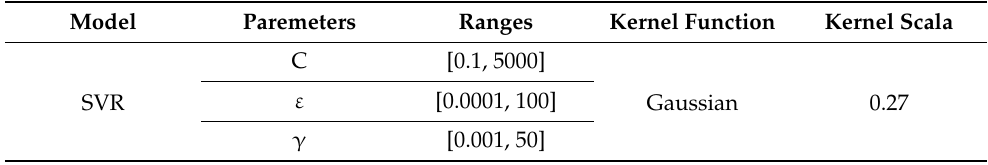
Table 7. Parameters for SVR Model.